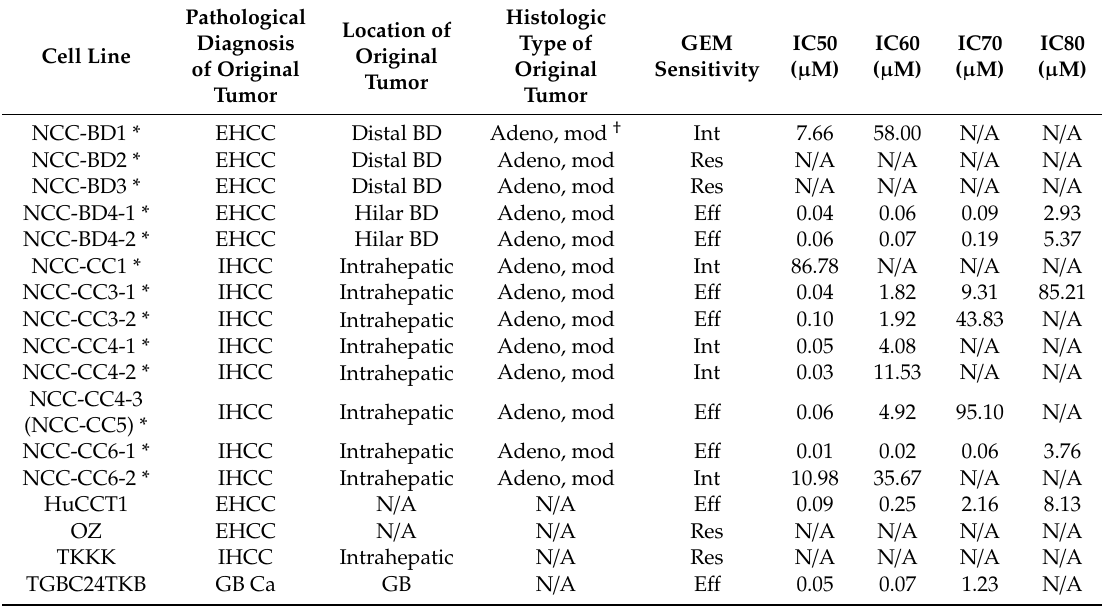
Table 1. IC50–IC80 values for GEM administration for each BTC cell